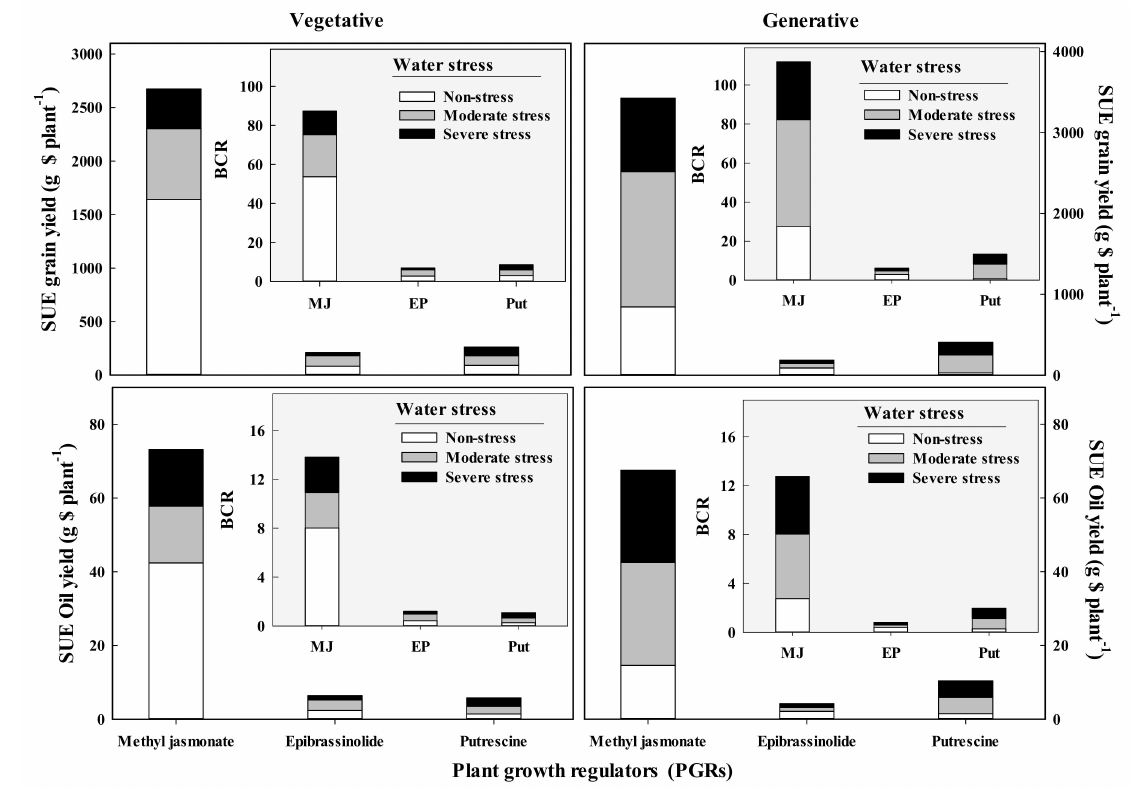
Figure 3. Spraying use efficiency (SUE) and benefit to cost ratio (BCR) of plant growth regulators on grain and essential oil yields of fennel ( Foeniculum vulgare Mill.) grown under different water stress intensity during the vegetative or generative